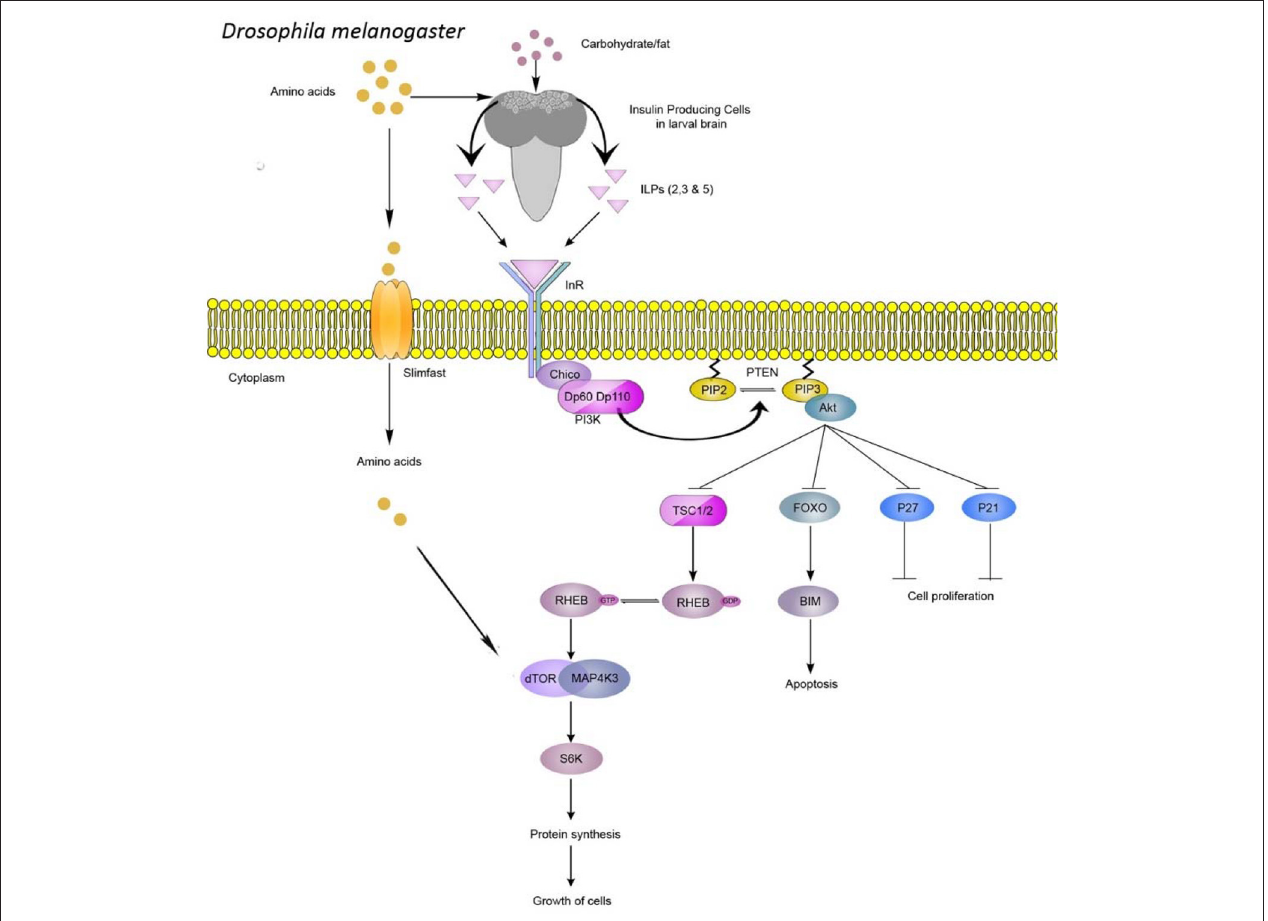
FIGURE 1 | PI3K/Akt pathway plays a central role in nutrient-mediated cell proliferation and growth. In Drosophila , amino acids, sugars, and fats control the release of insulin-like–peptides (ILPs), which bind the insulin receptor homolog (InR). Downstream signaling is mediated by insulin receptor substrate (Chico) binding to InR, followed by recruitment of phosphoinositide-3-kinase (PI3K), which leads to enzymatic conversion of phosphatidylinositol (3,4)-bisphosphate (PIP2) to PIP3. Akt kinase recognizes PIP3 to control cell proliferation and growth. TOR kinase can also be regulated by the availability of extracellular amino acids which enter the cell via Slimfast. TOR kinase activation leads to phosphorylation of effectors such as S6 kinase, which stimulates protein translation and cellular